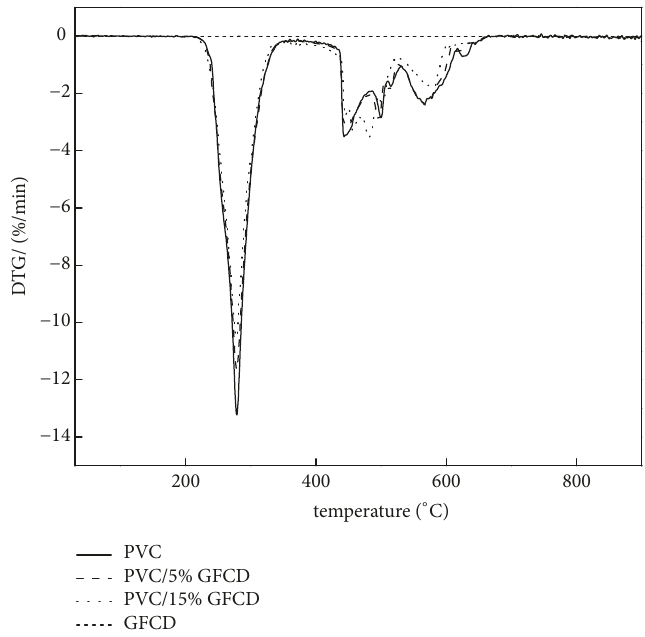
Figure 8: Sample thermograms of DTG of PVC, PVC/GFCD composites and filler